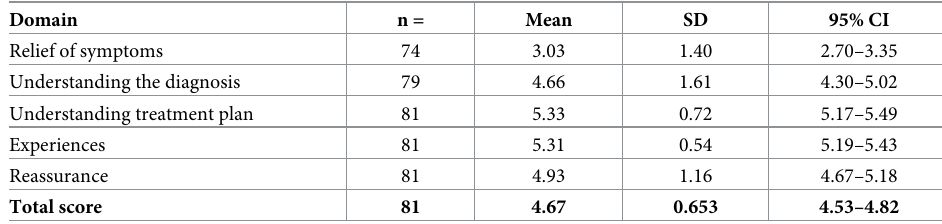
Table 4. Mean scores per